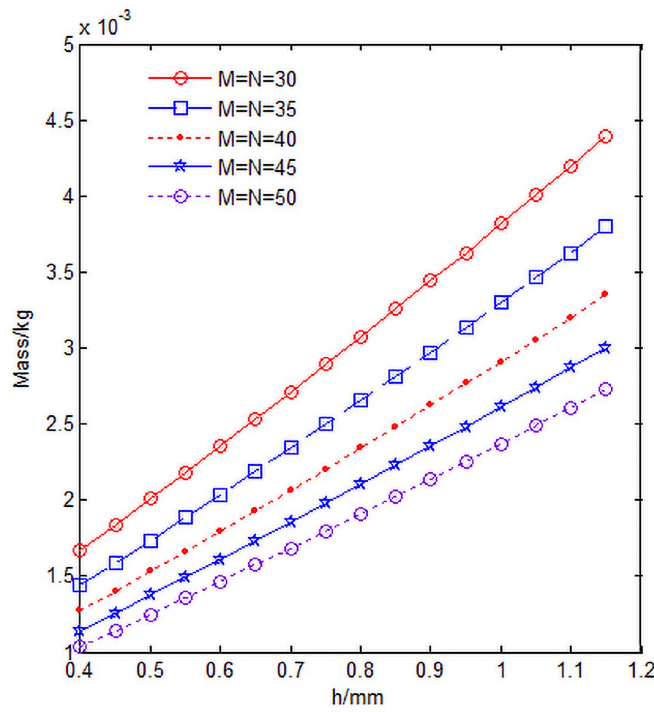
Fig 15. Relationship curve of unit cell mass m, knuckle length h and yarn